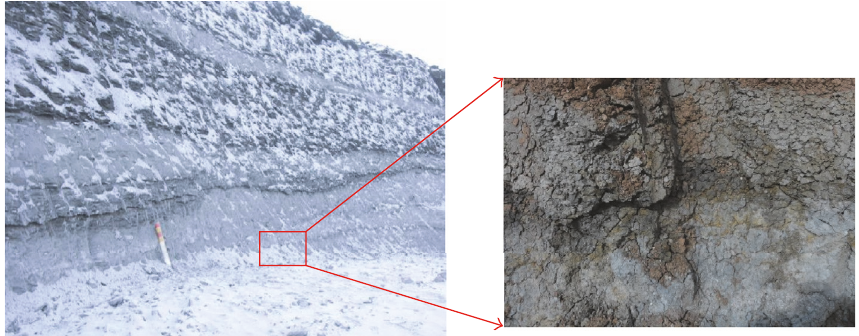
Figure 13: The deformation and fragmentation of new slope after undergoing the freezing and thawing cycle process.